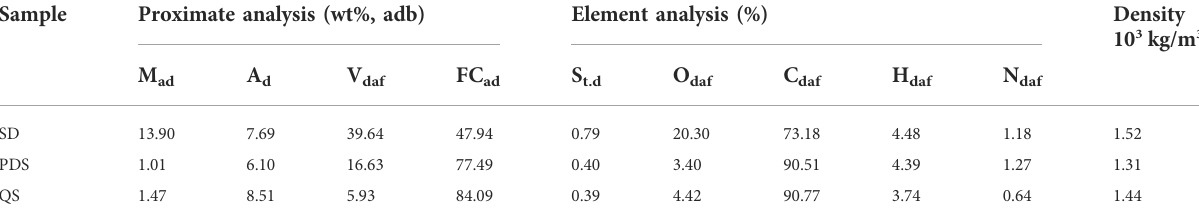
TABLE 1 Coal quality data of the sampled coals.